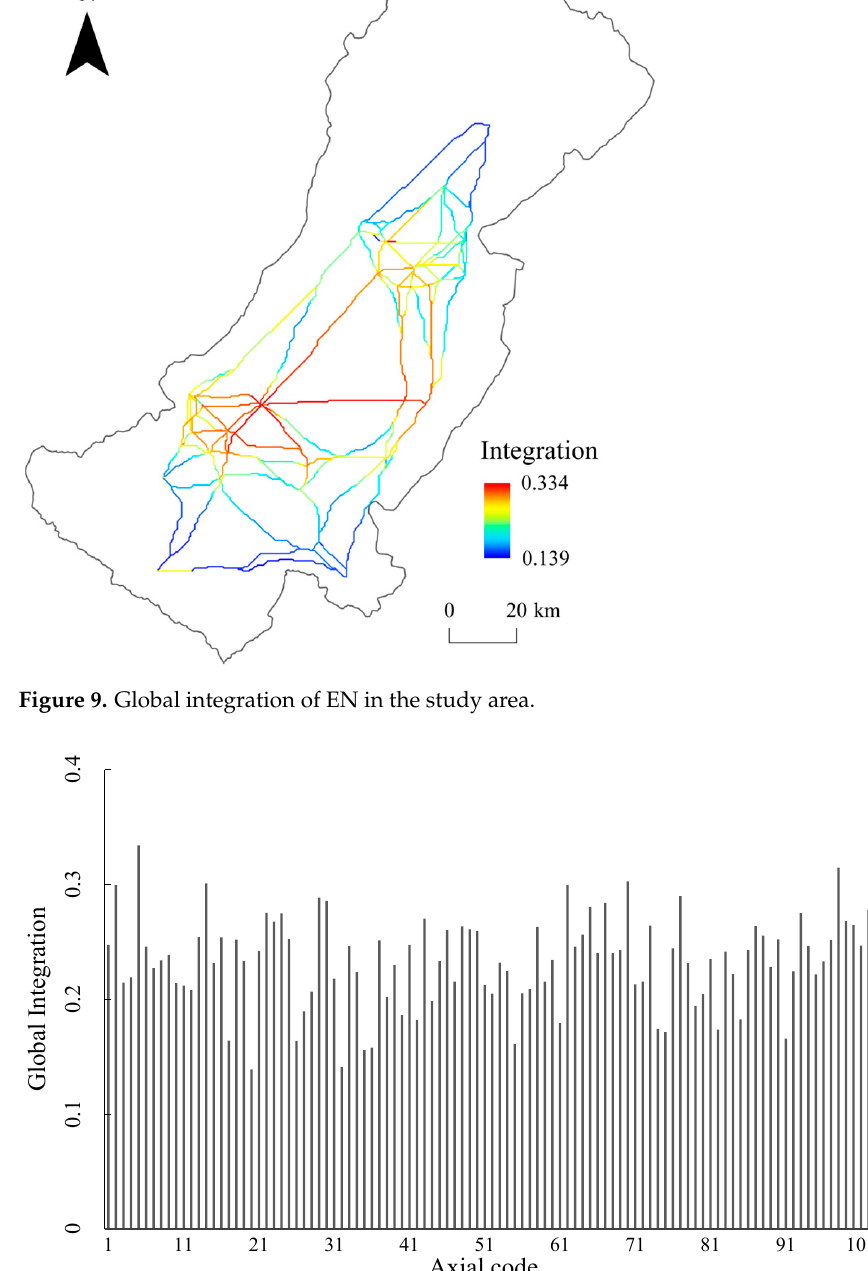
16 of 28 Figure 8. Distribution of Sub-optimal Path and “Pinch Points”. 4.2. EN Evaluation Results The global integration degree of the EN of the Taolai River Basin based on spatial syntax evaluation is shown in Figures 9 and 10. In Figure 9, the warmer the axis color, the higher the global integration degree and the higher the accessibility of the system. The colder the